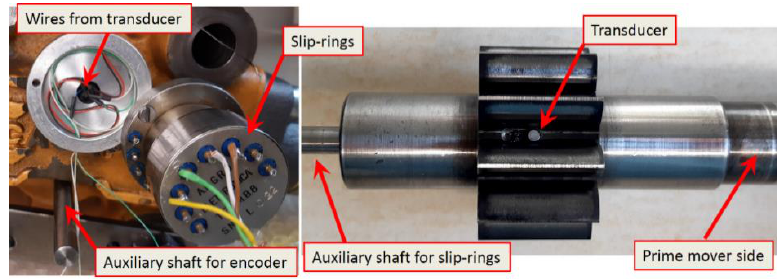
Figure 4. Pump features for measuring the chamber pressure.